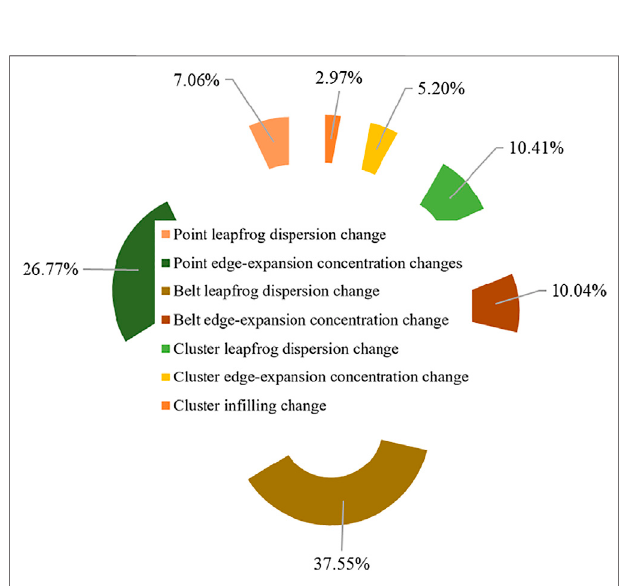
FIGURE 8 | Proportion of dynamic spatial patterns of RRL in